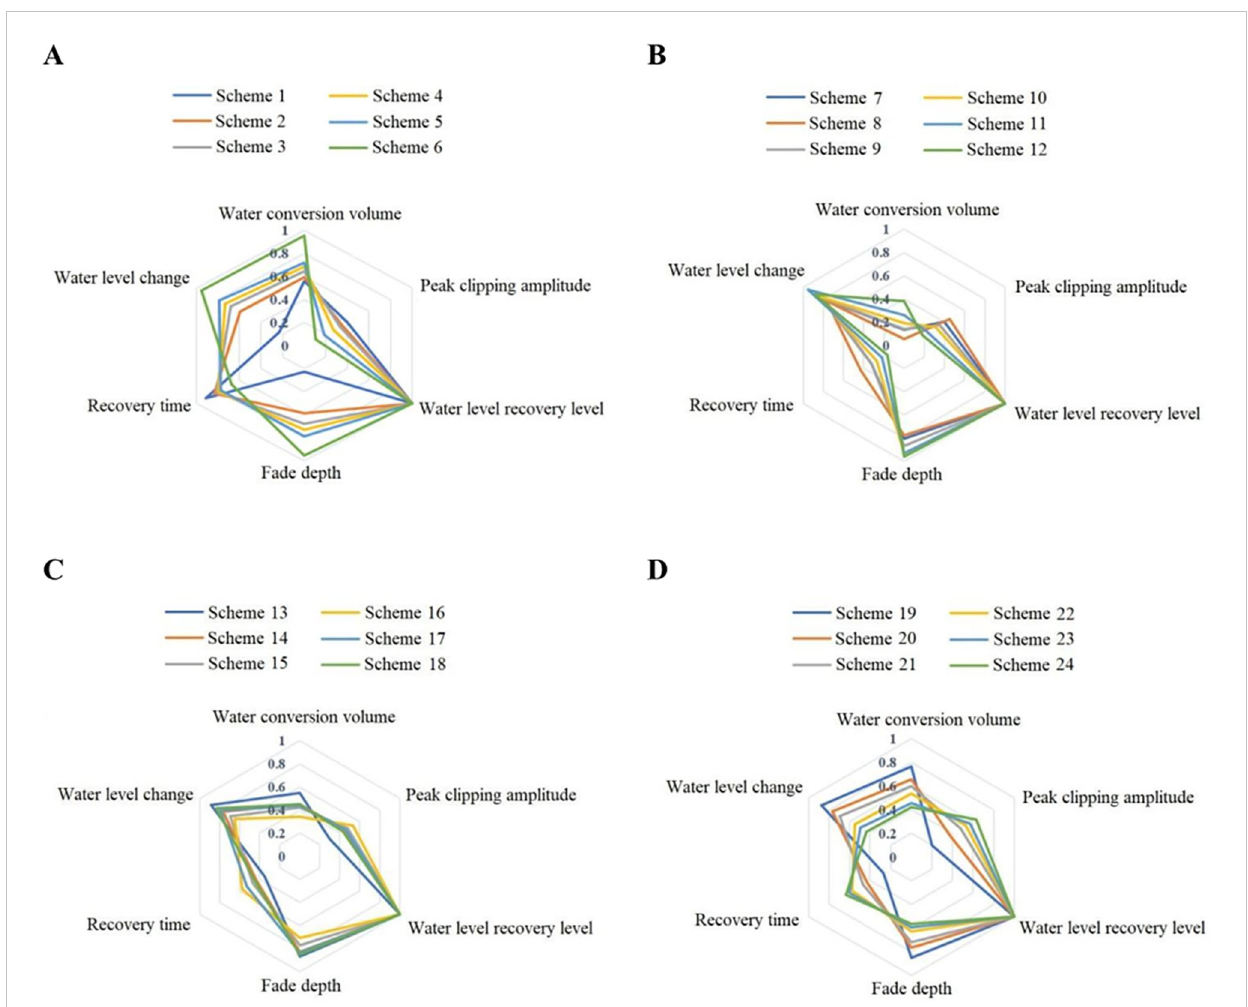
FIGURE 7 Radar chart of decision results of different schemes in dataset 1. (A) Scheme with pre discharge fl ow of 130. (B) Scheme with pre discharge fl ow of 200. (C) Scheme with pre discharge fl ow of 250. (D) Scheme with pre discharge fl ow of